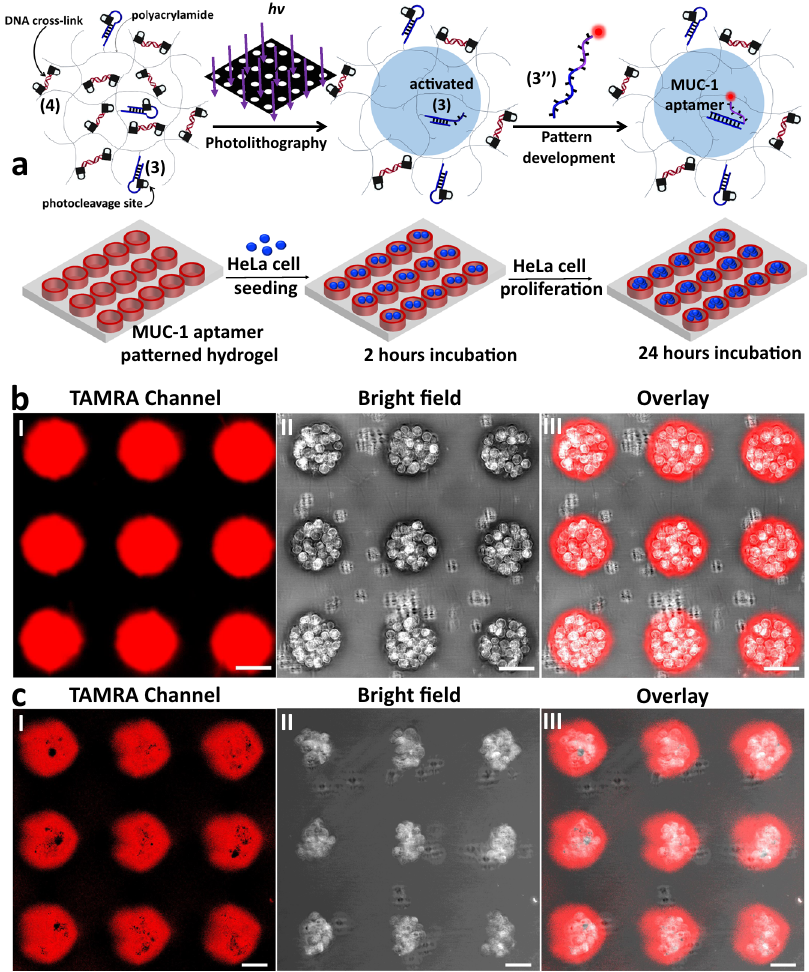
Fig. 7 Patterning of a photoresponsive hydrogel for the selective binding and proliferation of HeLa cells in the con fi ned patterned domains. a Photopatterning of circular domains functionalized with the toehold activated duplexes in the continuous (4)-crosslinked hydrogel matrix modi fi ed with hairpins (3). The TAMRA-(3 ” ) conjugated with MUC-1 aptamer are hybridized with the activated (3)-duplex to yield functional domains for the selective binging of HeLa cells and for the concomitant fl uorescence imaging of the patterned cell structures. b Panel I — The confocal fl uorescence microscope image of the TAMRA-(3 ” ) modi fi ed patterned hydrogel fi lm. Panel II – Bright fi eld image of the HeLa cells linked to the con fi ned circular domains modi fi ed with MUC-1 aptamer. Panel III – Overlay image of panel I and panel II. Scale bars are 50 μ m. c Panel I — Fluorescence confocal microcopy image (TAMRA channel) of the TAMRA-(3 ” ) in the patterned domains. Panel II — Bright fi eld confocal image of the proliferated cells in the patterned domains. Panel III — Overlay of panel I and panel II. Scale bars are 50 μ m. N = 4 independent experiments were